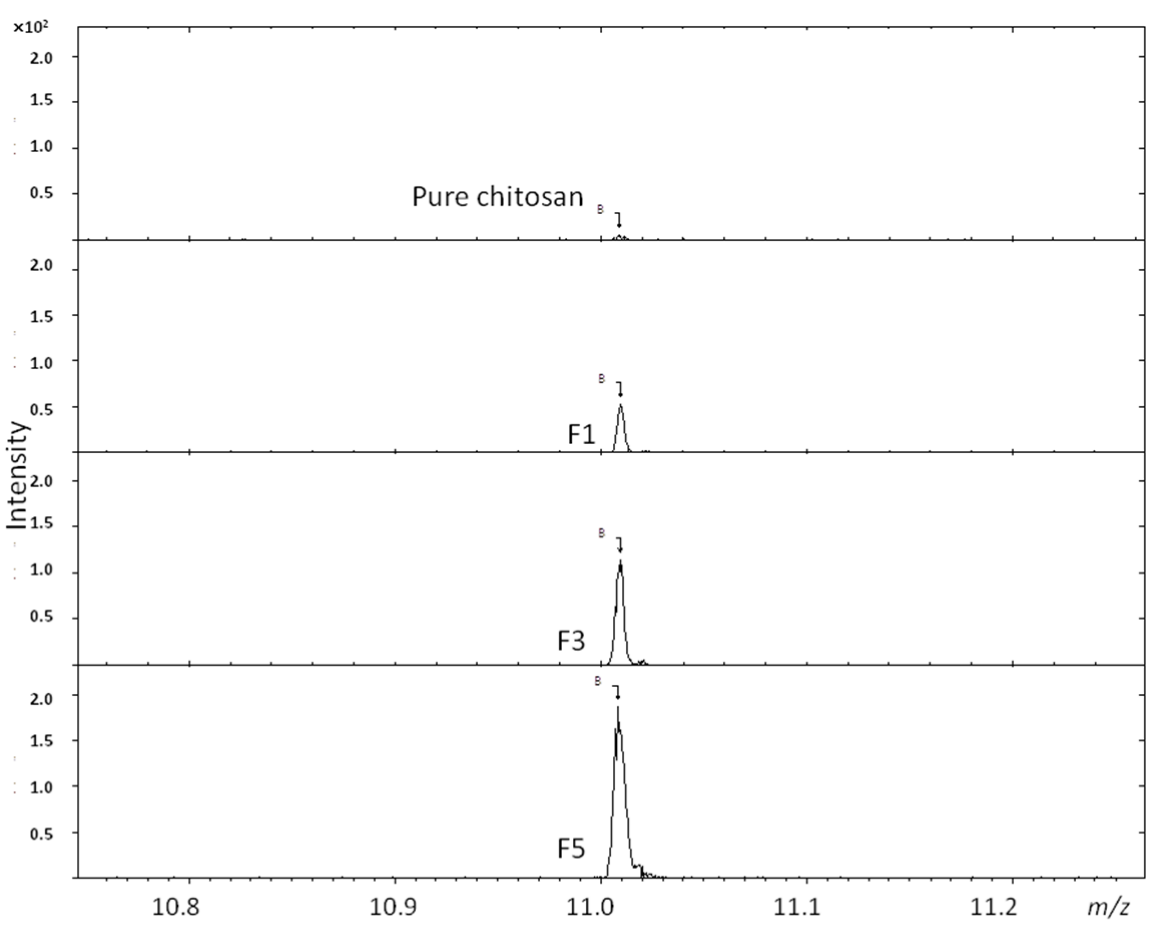
Figure 2. ToF-SIMS analysis of boron ion (B − ) at 11.01 m / z from conjugates F1, F3 and